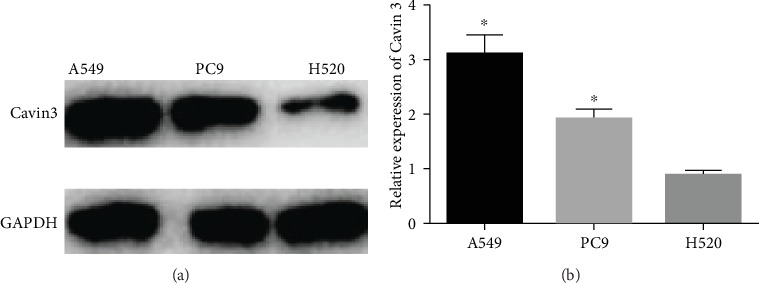
Differential expression of Cavin3 in lung cancer cell lines with different biological characteristics. (a) Protein bands of Cavin3 in different lung cancer cells lines and (b) corresponding expression levels (∗ means p < 0.05).